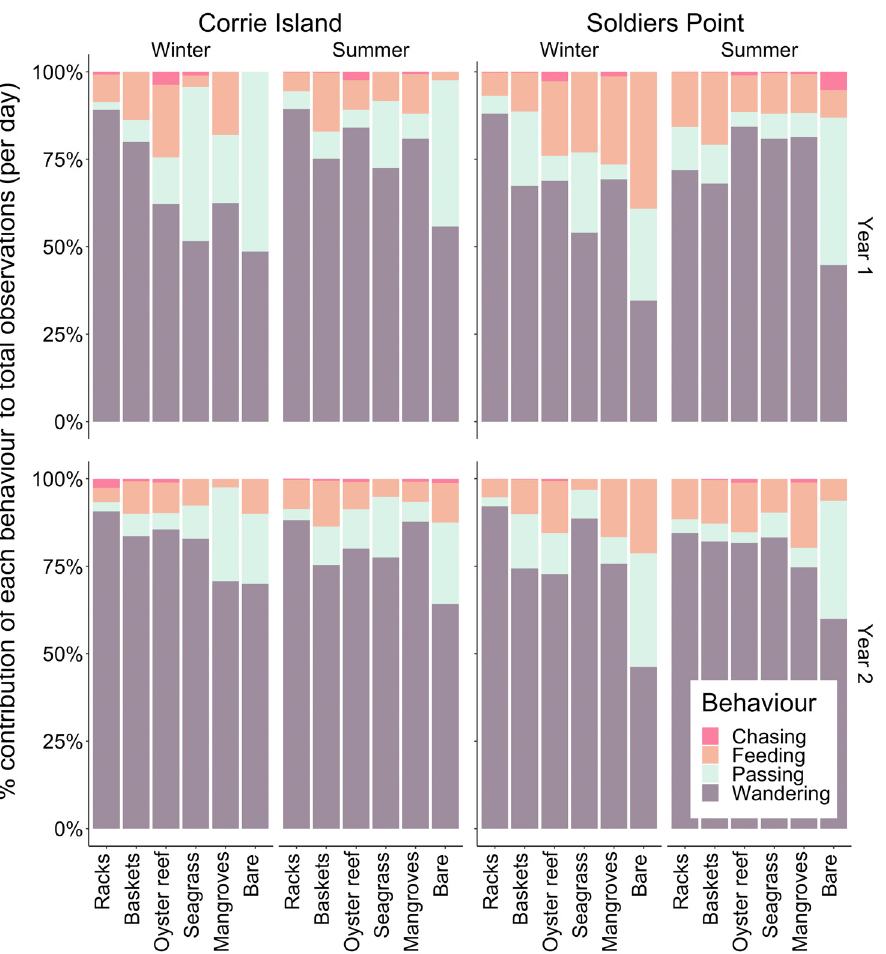
Fig. 7. Mean percentage contribution of each behaviour to total observations recorded during 75 min remote underwater video deployments for each habitat, site, season and year (n =